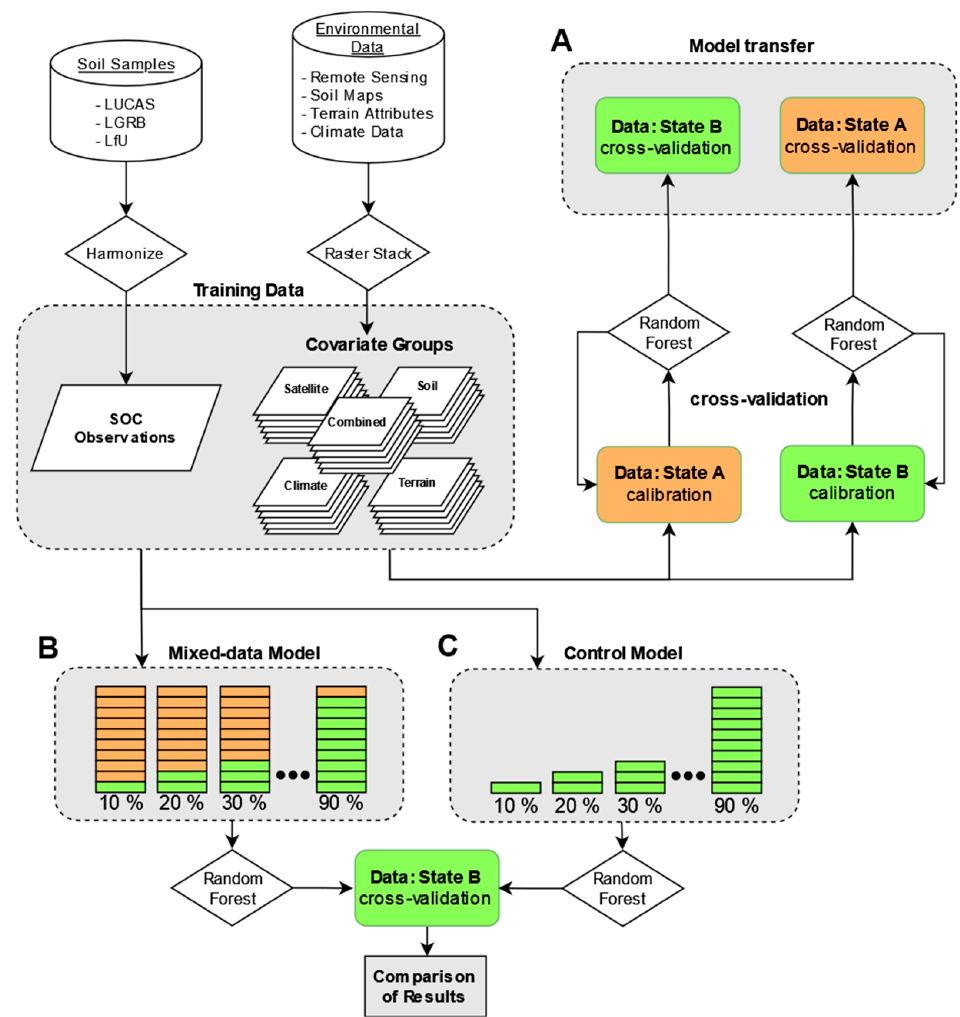
Figure 2. Flowchart of the SOC prediction and model transfer. ( A ) For each covariate group, models were trained with soil samples from one state and tested with samples from the other one. ( B ) Mixed-data models were trained with samples from both states to evaluate the effect of additional data. Nine models (10–90%) with different proportions were trained for all covariate groups and both states. The results were compared to control models built without the additional data ( C ).